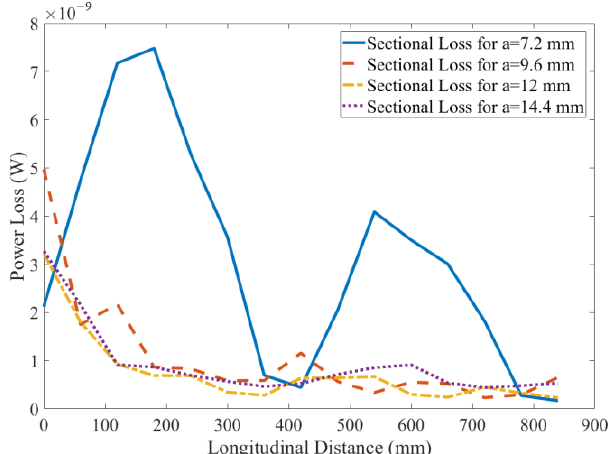
Figure 9. Power losses as a function of frequency under different space length. The period length of the array is twice the space length, which is the distance between the simulation boundary and the model.